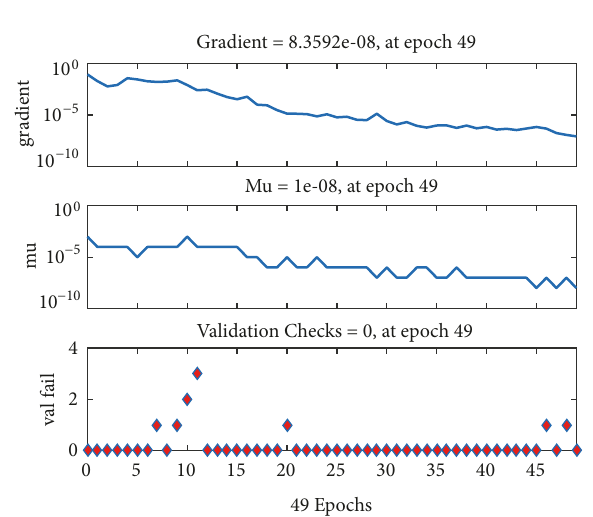
Figure 21: Training state diagram of BP neural network.